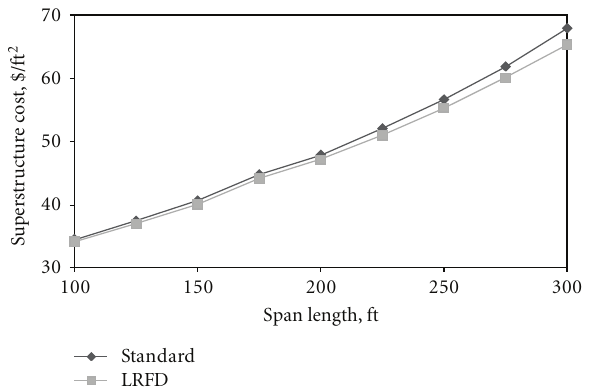
Figure 6: Superstructure cost, $/ft 2 for a box girder (seven cells spaced at 9ft).